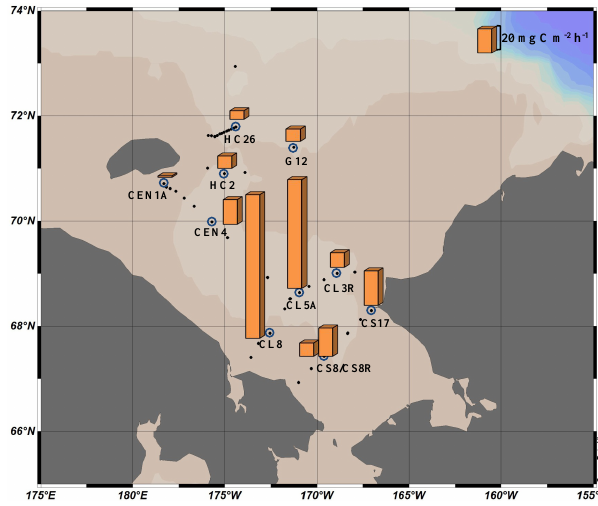
Figure 6. Hourly nitrate and ammonium uptake rates (mgNm − 2 h − 1 ) integrated from the surface to 1% light depth during the 2012 RUSALCA